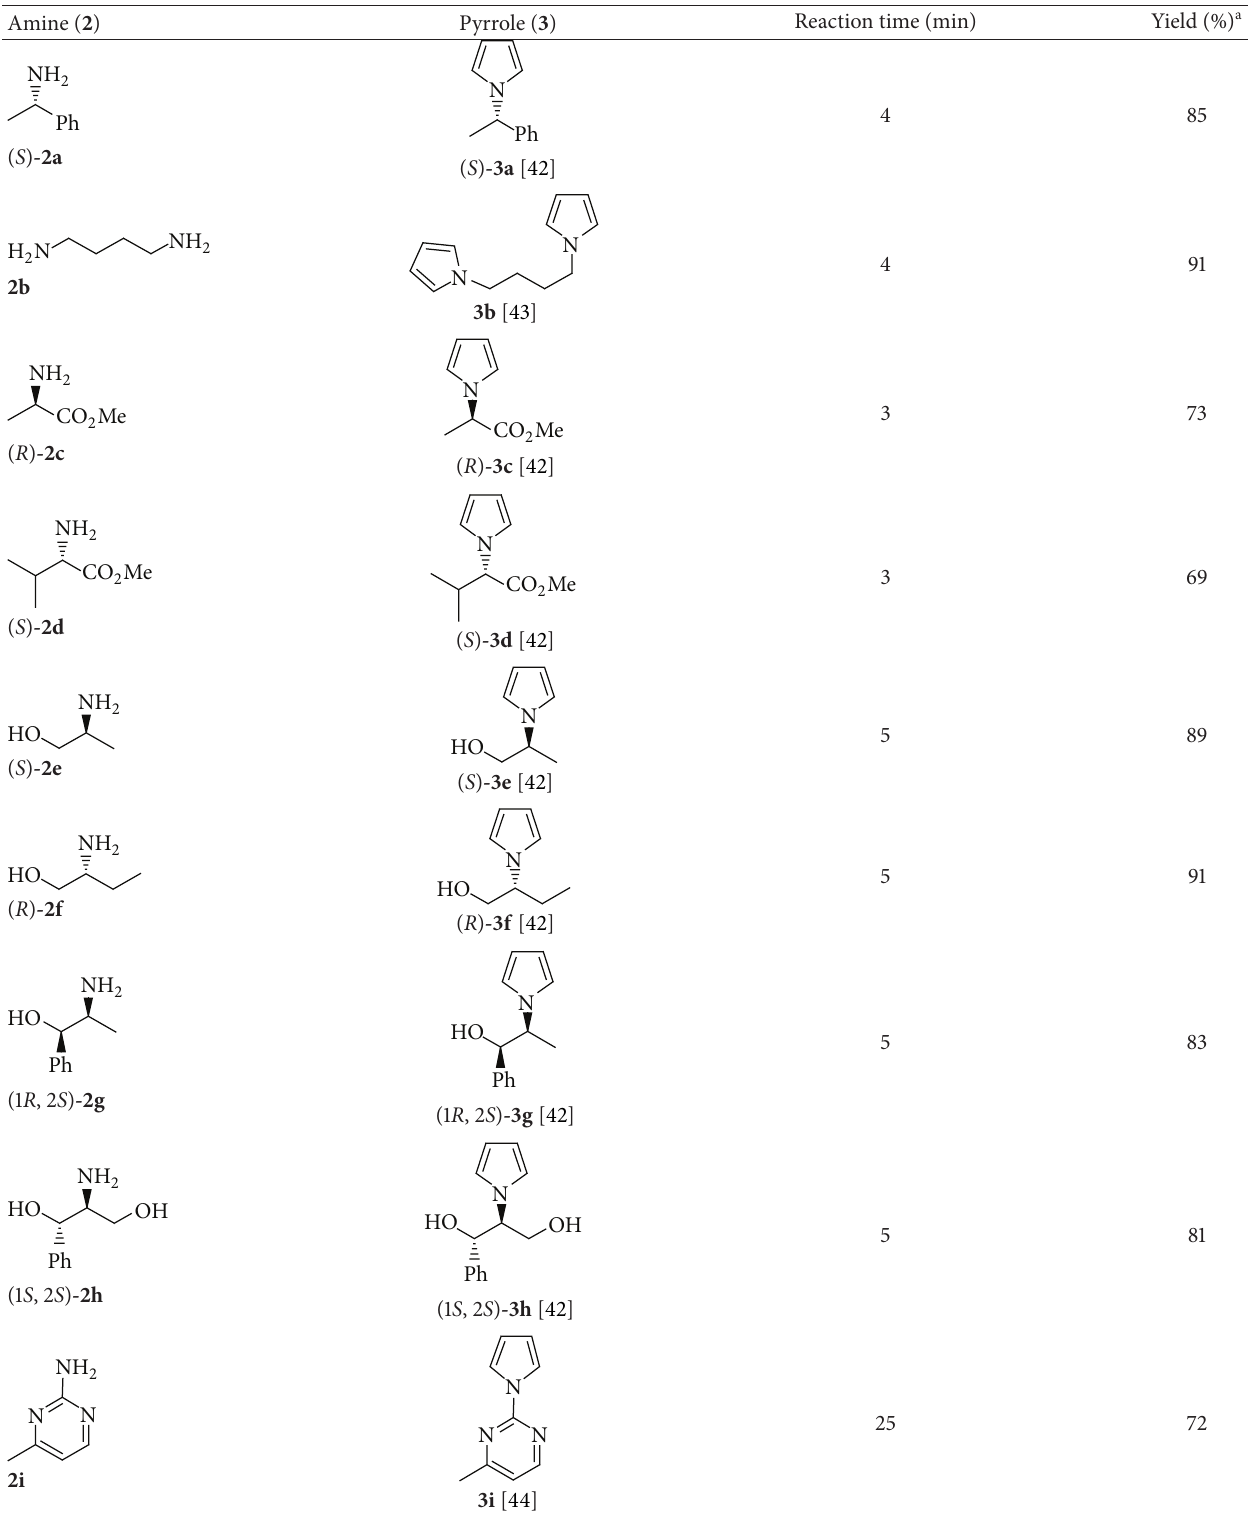
Table 2: The synthesized pyrrole